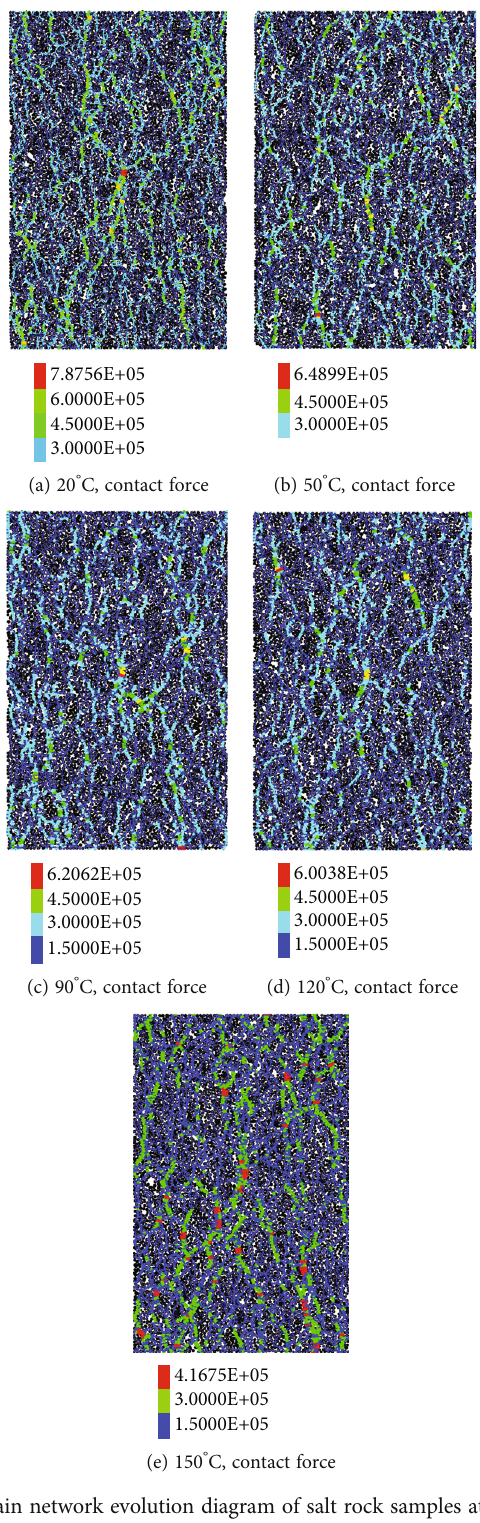
Figure 8: The force chain network evolution diagram of salt rock samples at di ff erent